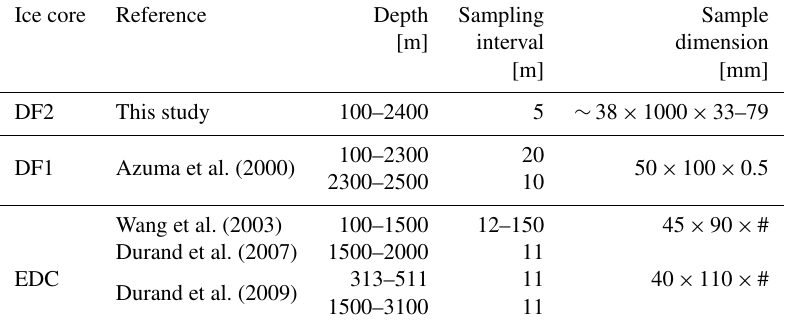
Table 1. Comparison of sampling intervals and dimensions (width × height × thickness) for each ice core. The sample width in the present study indicates the half-power diameter of the Gaussian beam. Although the precise thicknesses of thin sections are not provided in Wang et al. (2003) or Durand et al. (2007, 2009) (missing data are indicated by the # symbol in this table), it can be assumed that the thicknesses of sections prepared for optically based COF measurements were approximately 0.5mm or